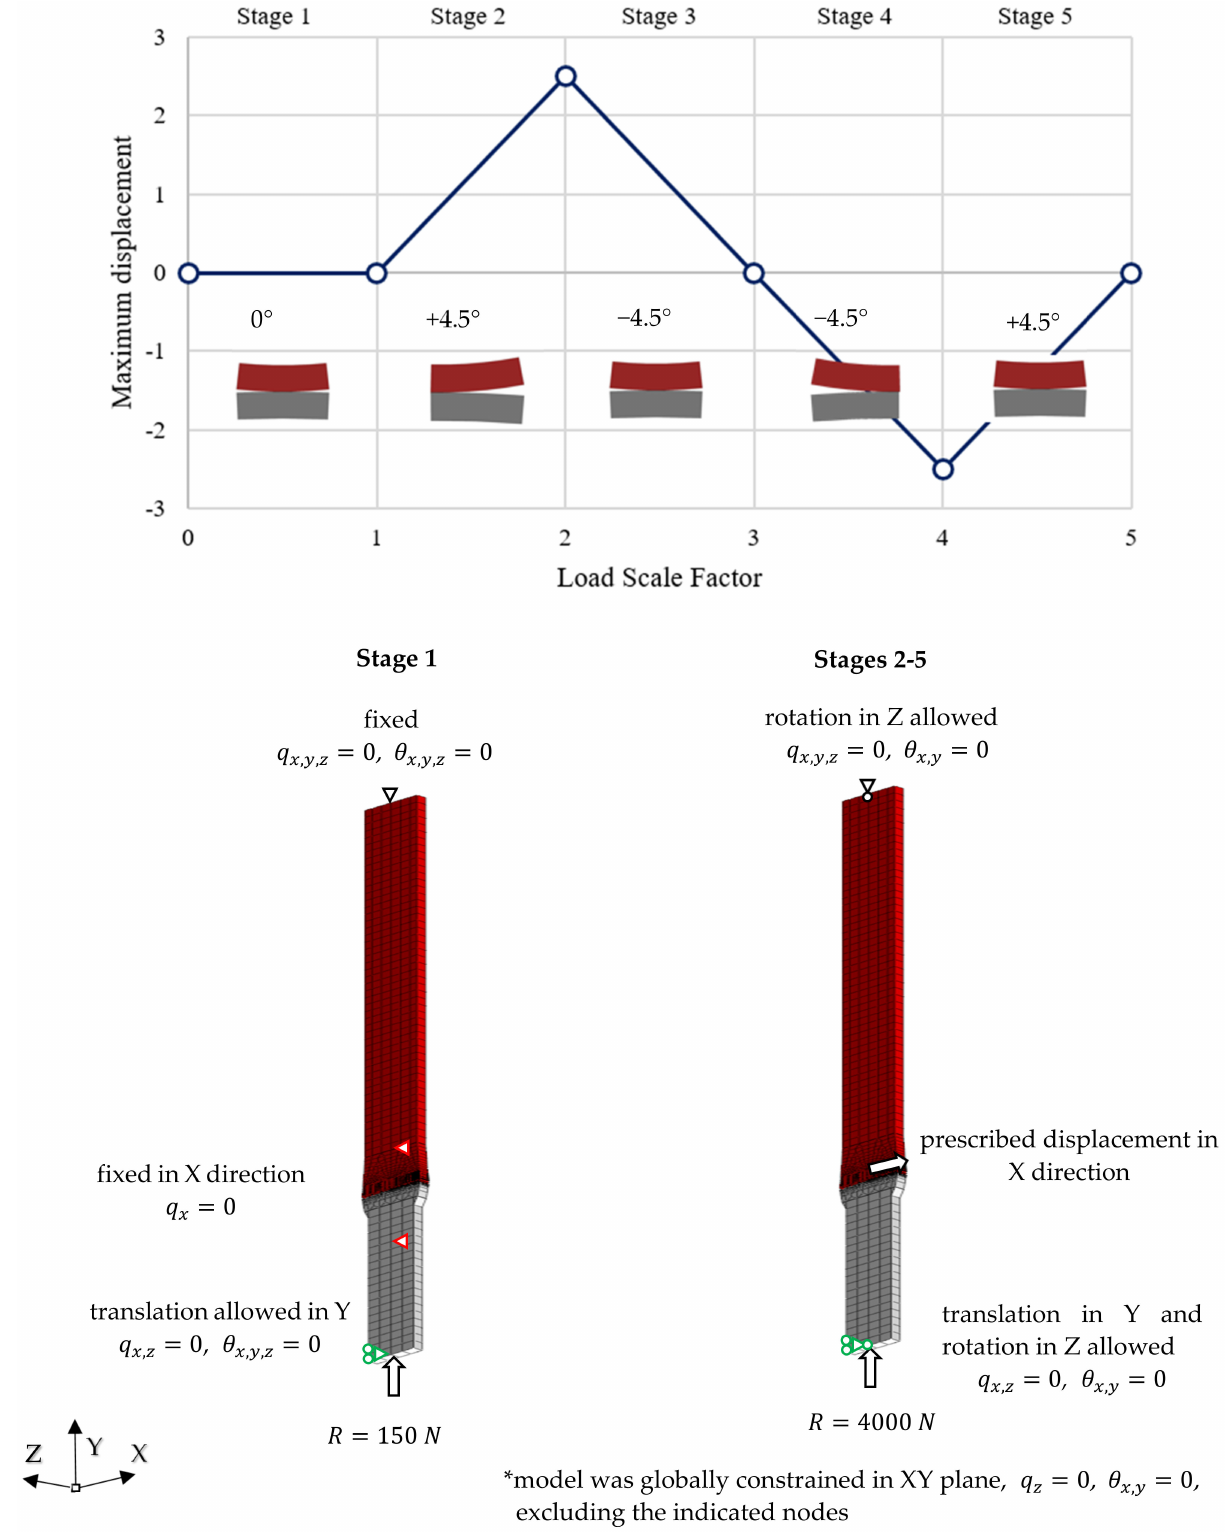
Figure 10. Stages of simulation calculations when shifting the shaft journal over a support roller over a distance of 5 mm. Therefore, considering that there are no permanent deformations in the support roller, the stress analyses were limited to residual stresses occurring in the surface layer of the shaft. Of course, not only were the stress values analyzed, but the permanent